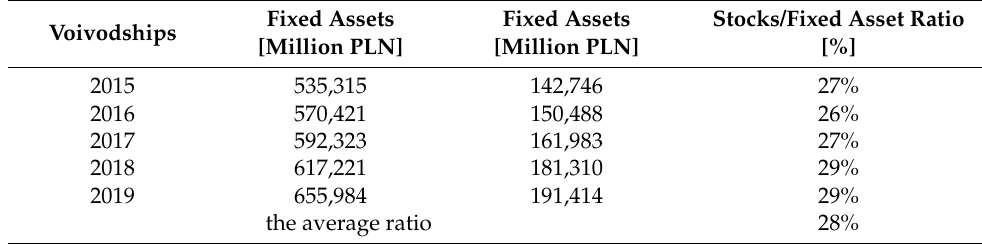
Table 8. The ratios of stocks to fixed assets in the industry sector in 2015–2019 (in current